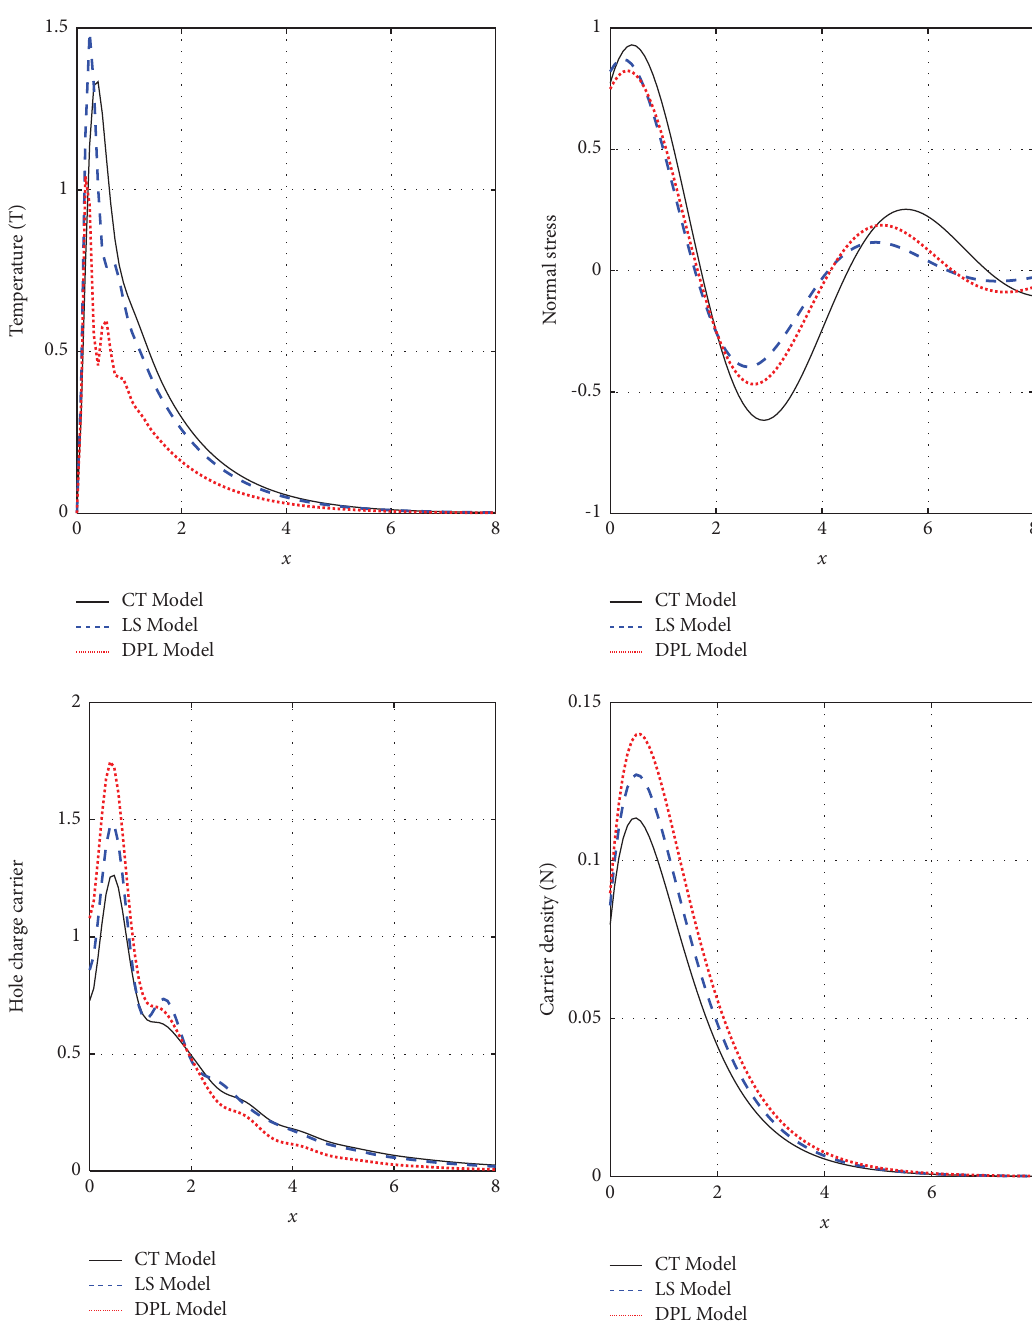
Figure 1: Te variation of the main physical distributions against the distance according to photo-thermoelasticity models with variable thermal conductivity under the efect of Hall